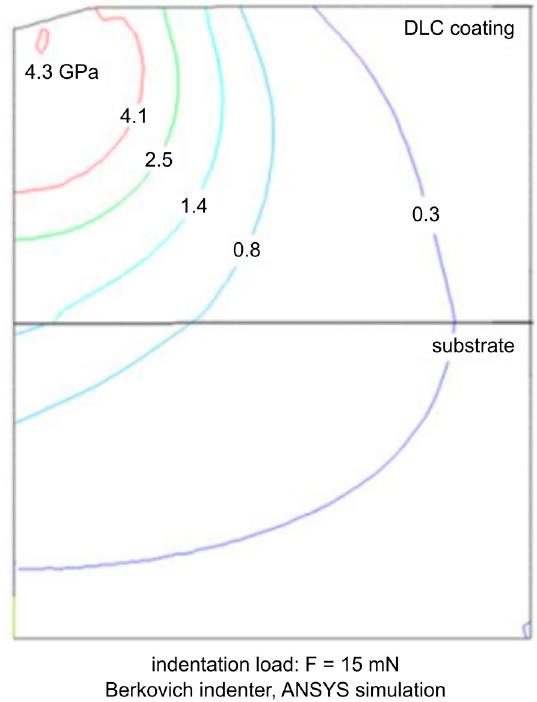
Figure 8. Developed stress fields in the DLC coating and its HSS substrate.